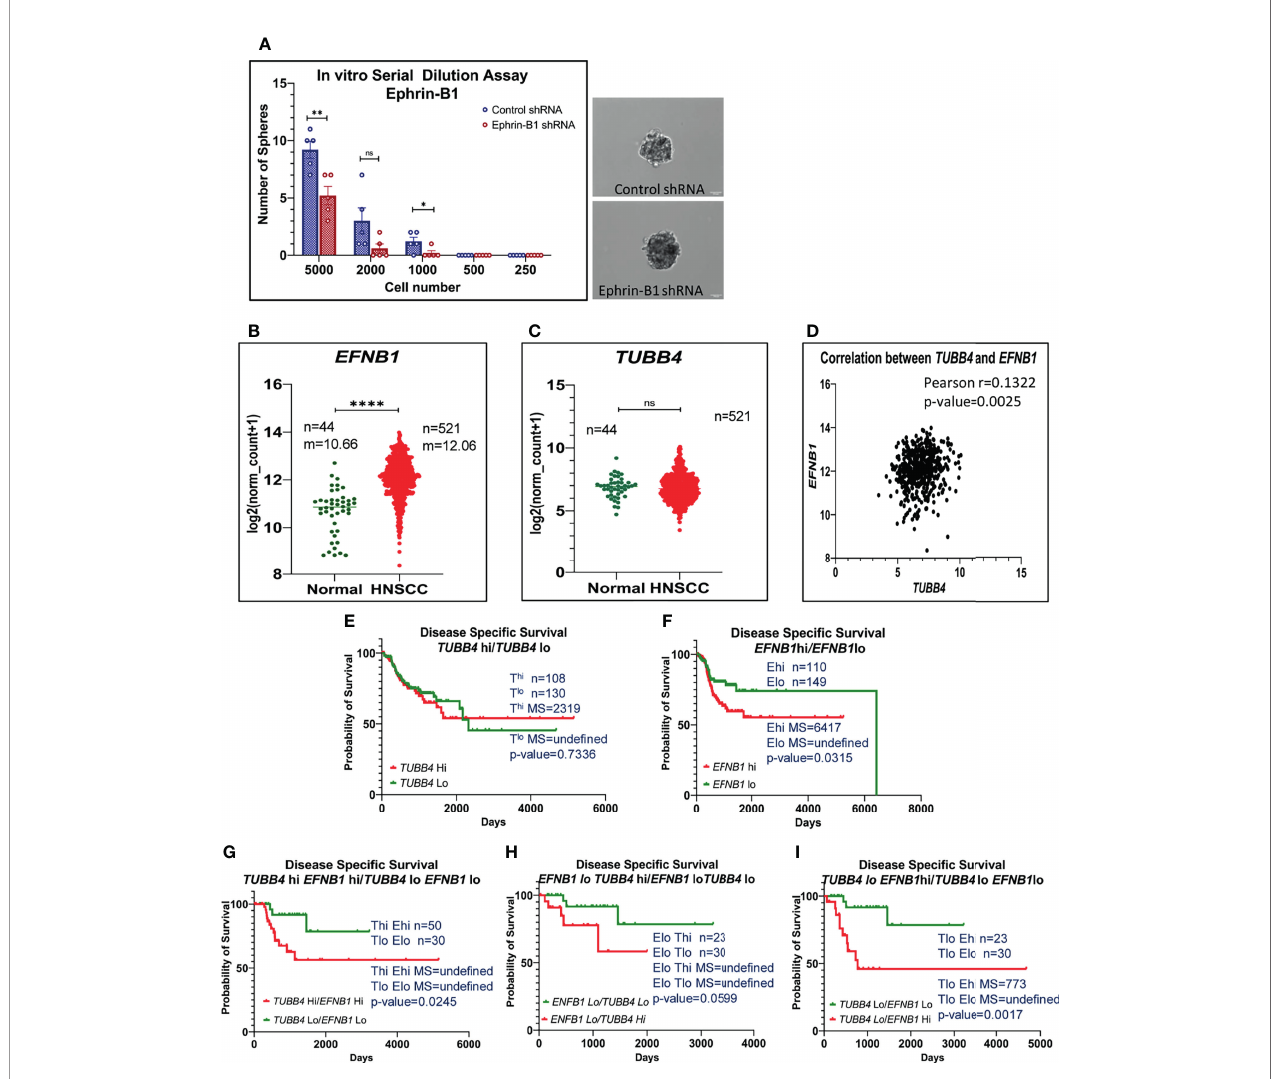
FIGURE 4 | High expression of TUBB4B with Ephrin-B1 predicts poor prognosis in HNSCC. Serial dilutions of control shRNA induced and Ephrin-B1 shRNA harboring HSC3 cells were plated in low adhesion plates in replicates and monitored for sphere formation for 10 days. The number of spheres formed in each dilutions of both groups are represented in the bar graph (A) . Representative images of spheres formed in control shRNA and Ephrin-B1 shRNA groups are also shown. Scale bar is 100 m m. To analyze mRNA expressions, log2(x+1) transformed RSEM normalized count of EPHB1 (B) and TUBB4B (C) from 521 HNSCC patients was plotted against 44 normal samples obtained from RNAseq data of TCGA database was performed by using GraphPad prism 9.0. The statistical signi fi cance was calculated by unpaired t-test. (D) Two-tailed Pearson correlation analysis between TUBB4B and EFNB1 RNA normalized counts of 521 HNSCC patients was performed. Kaplan – Meier analysis was carried out between (E) TUBB4B hi (>7.5) and TUBB4B lo (<6) samples, (F) EFNB1 hi (>12.5) and EFNB1 lo (<11.5) samples (G) TUBB4B hi (>7.5) EFNB1 hi (>12.5) and TUBB4B lo (<6) EFNB1 lo (<11.5) samples (H) EFNB1 lo (<11.5) TUBB4B hi (>7.5) and EFNB1 lo (<11.5) TUBB4B lo (I) TUBB4B lo (<6) EFNB1 hi (>12.5) and EFNB1 lo (<11.5) TUBB4B